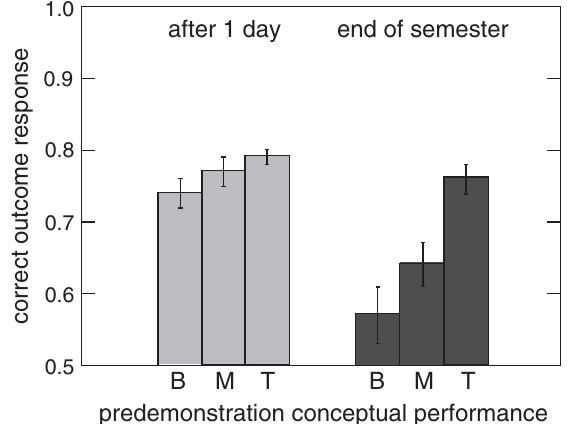
FIG. 2. Average percentage of correct response to the outcome question asked one day after the demonstration (light gray) and at the end of the semester (dark gray), for students at three different levels of performance on the predemonstration con- ceptual questions: bottom third of the class (B), middle third of the class (M), and top third of the class (T).